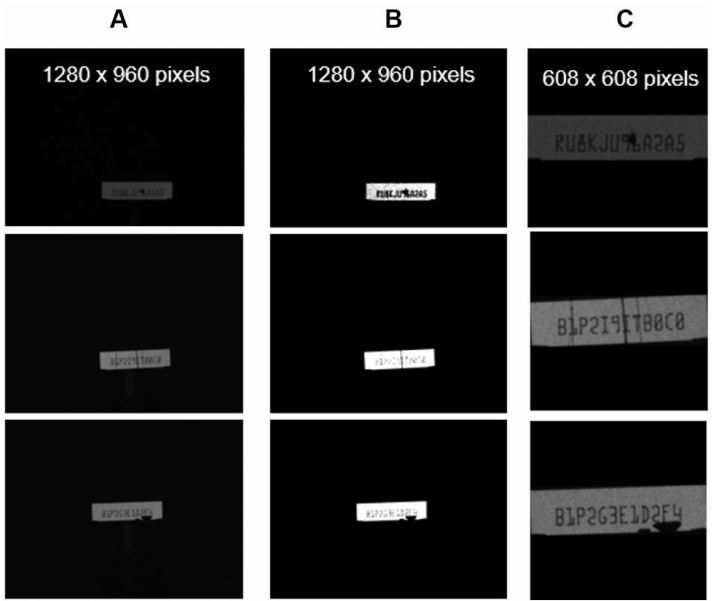
Figure 6. OCR data preparation. ( A ) original captured images with variations of image contrast and shifting of region of interest (ROI), ( B ) thresholding and edge detection, and ( C ) ROI cropping and